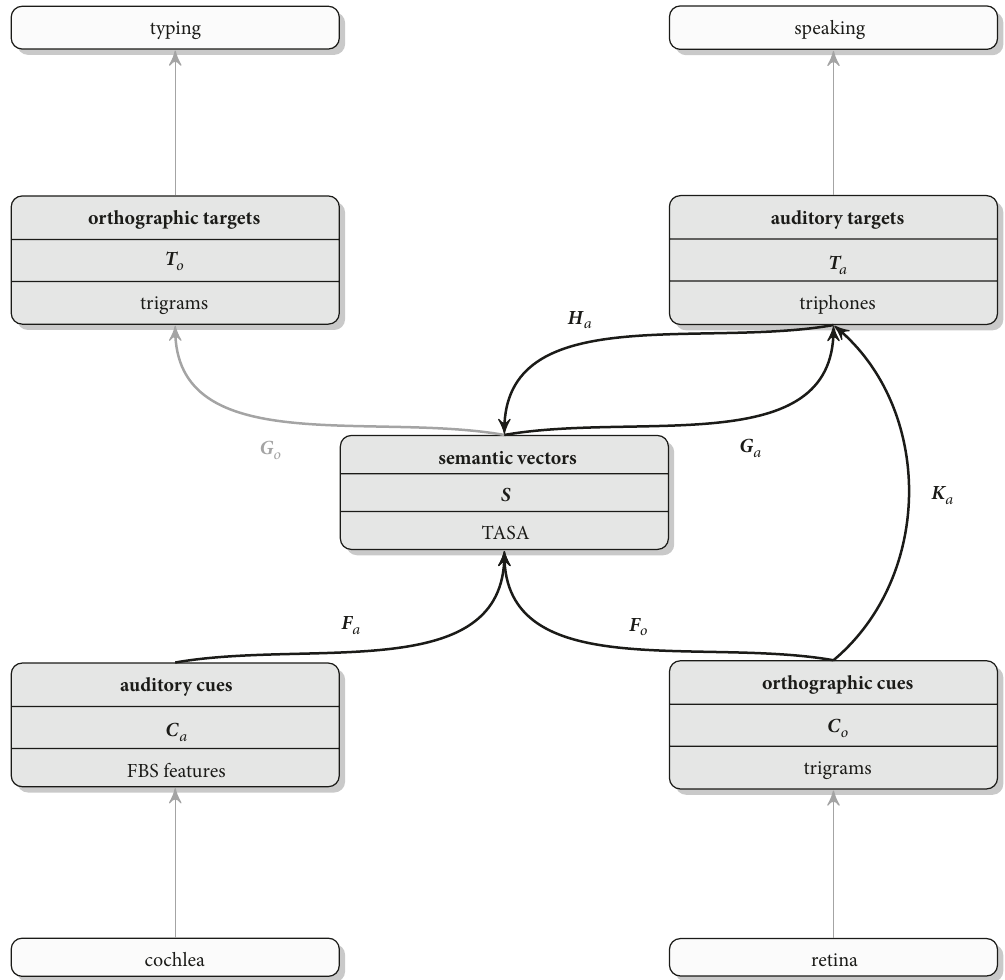
Figure 11: Overview of the discriminative lexicon. Input and output systems are presented in light gray, the representations of the model are shown in dark gray. Each of these representations is a matrix with its own set of features. Arcs are labeled with the discriminative networks (transformation matrices) that map matrices onto each other. The arc from semantic vectors to orthographic vectors is in gray, as this mapping is not explored in the present